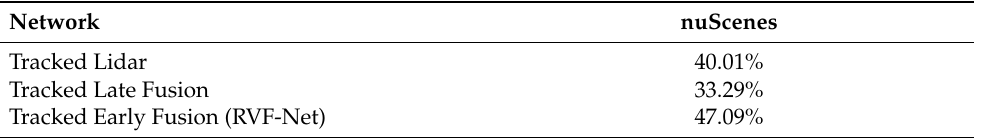
Table 5. AP scores of the tracked sensor inputs. The early fusion RVF-Net outperforms the late fusion by a great